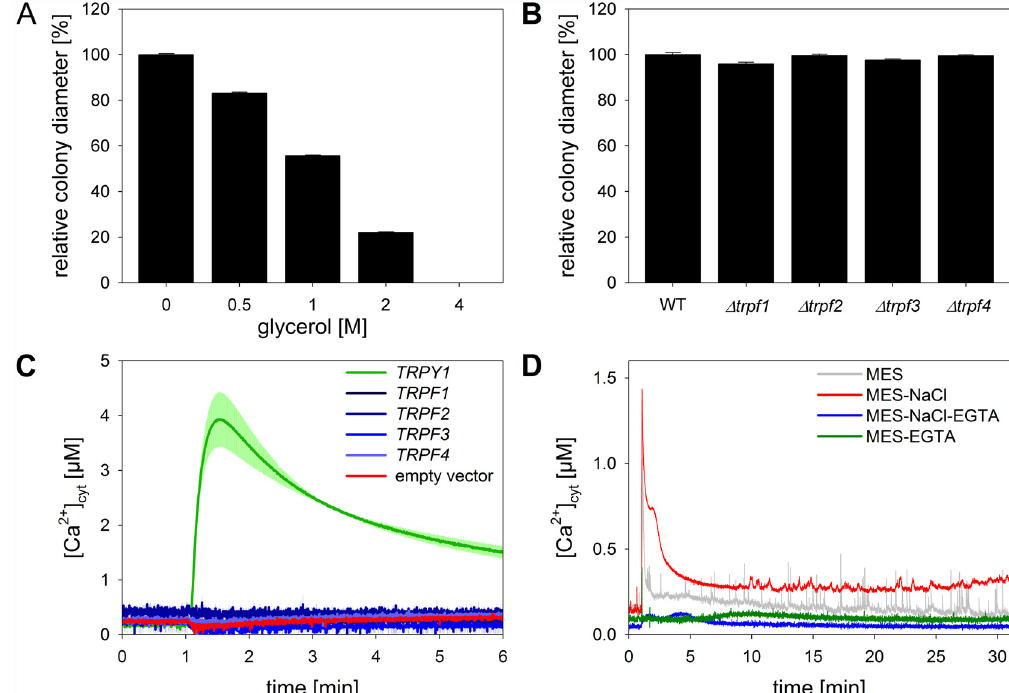
Fig 9. Response of mycelial growth of C . graminicola and [Ca 2+ ] cyt of C . graminicola and yeast to hyperosmotic stress. (A, B) Mycelial growth of C . graminicola osmotically stressed with glycerol. (A) Colony diameter of wild type stressed with varying concentrations of glycerol, normalized to unstressed colonies. (B) Wild type and deletion strains stressed with 0.5 M glycerol, normalized to the wild type. Colony diameters were determined 122 hours post inoculation. Data are means ± SE (N = 3). (C, D) [Ca 2+ ] cyt response of yeast and C . graminicola to NaCl measured by aequorin luminescence. (C) Response of trpy1 Δ yeast mutant cells transformed with the indicated vectors to a solution (pH 7.0) containing 1.5 M NaCl, 50 mM MES-KOH, and 25 mM EGTA. Treatment was started at 1 min. Red line: empty pFL61 vector (negative control); green line: pFL61-ScTRPY1 (positive control); blue lines: yeast strains transformed with pFL61 containing CgTRPF1 through 4 . Data are means ± SE (N = 3). (D) [Ca 2+ ] cyt measurements on C . graminicola wild type colonies. Whole colonies were pre- treated with 50 mM MES-KOH (pH 7.0) for 30 min prior to recording, followed by treatment with a solution (pH 7.0) containing 50 mM MES-KOH and no NaCl (grey line) or 1.5 M NaCl (final concentration; red line). To abolish the influx of extracellular Ca 2+ , colonies were pre-treated with a solution (pH 7.0) containing 50 mM MES-KOH and 25 mM EGTA for 30 min prior to measurement, followed by treatment with a solution (pH 7.0) containing 50 mM MES-KOH, 25 mM EGTA, and no NaCl (green line) or 1.5 M NaCl (final concentration) (blue line). Treatment solutions were added after 1 min of recording. Traces show individual measurements in order to